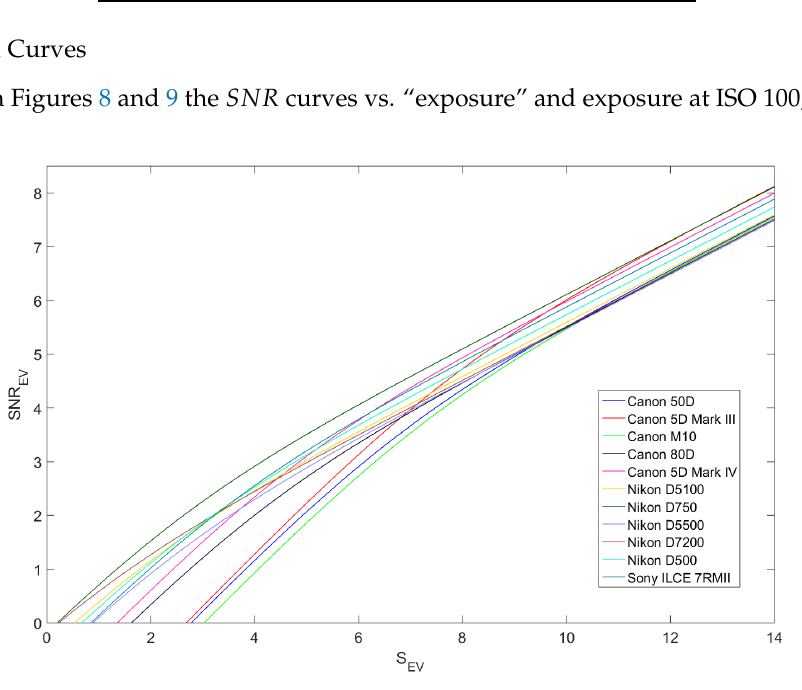
Figure 8. Pixel SNR vs. RAW value for ISO